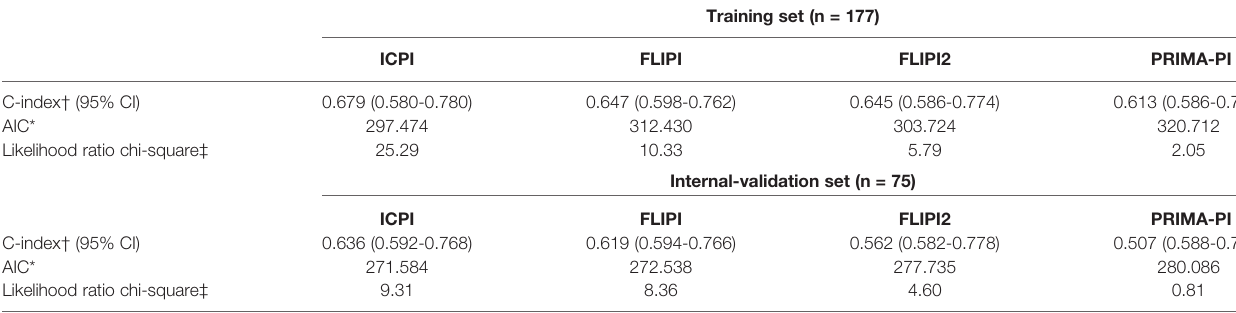
TABLE 2 | Comparisons between model performance for